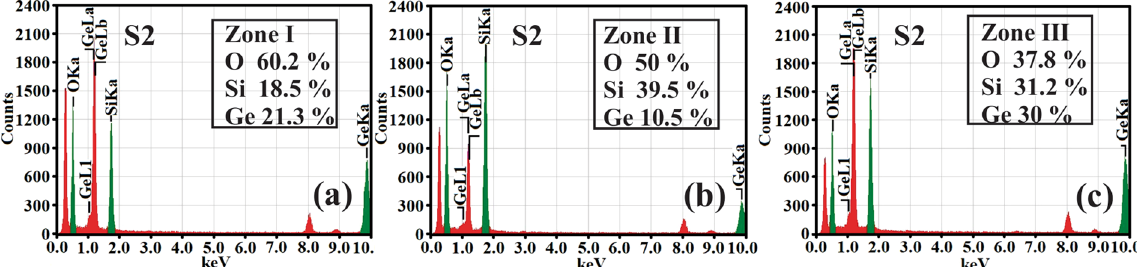
Figure 4. EDX spectra obtained from selected area in the three zones from Fig. 3a: ( a ) zone I at the top of the film indicates the presence of an amorphous SiGe oxide; ( b ) zone II (under zone I) is rich in SiO 2 and depleted in Ge content; ( c ) zone III, the largest one positioned at the bottom of the film contains SiGe NCs embedded in oxide matrix.